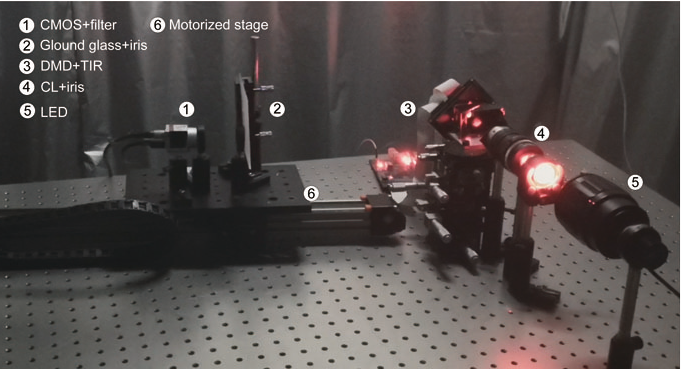
Figure 2. Schematic of Speckle collecting